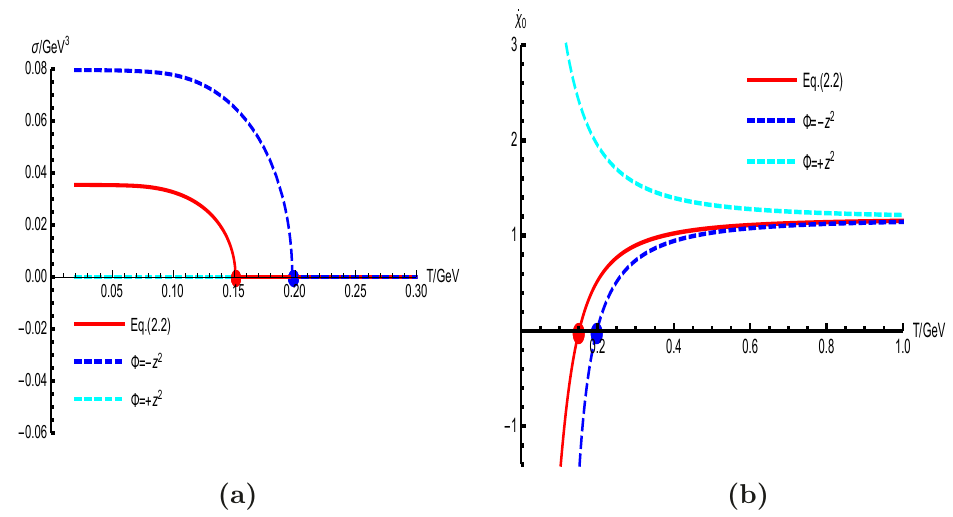
Figure 4 . Temperature dependent chiral condensate (panel.(a)) and the corresponding solution of ˙ χ 0 (panel.(b)), with dilaton in eq. (2.2)(the red solid lines), Φ = z 2 (the blue dashed lines), Φ = z 2 − (the cyan dashed lines). The scalar potential takes the form v 3 = 0 , v 4 = 8. The red and blue dots represent the transition temperature, which locates at T = 0 . 1515 . . . GeV and T = 0 . 1980 . . . GeV for dilaton in eq. (2.2) and Φ = z 2 respectively. The high temperature limit of all the three lines − Γ 2 ( 1 4 ) 1 . 18, with ψ ( n ) ( z ) the n th derivative of the are the same and approach 2 √ π ( ψ (0) ( 1 4 ) ψ (0) ( 3 4 )) ≈ − − ′ Γ ( z ) digamma function ψ ( z ) Γ( z ) ≡